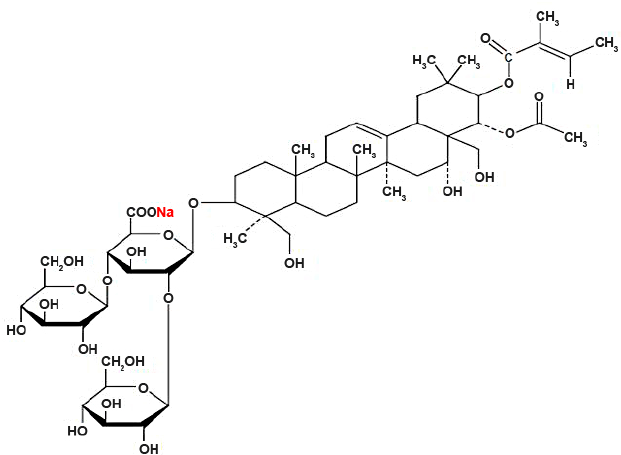
Figure 4. Chemical structure of sodium aescinate (SA).